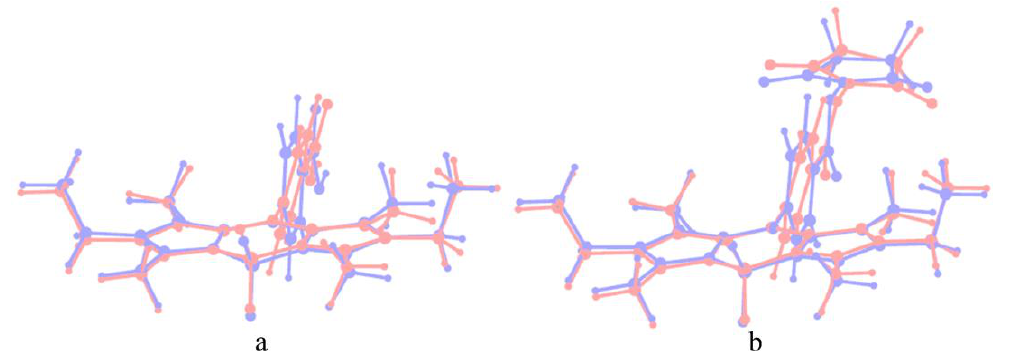
Figure 3. Ground S 0 (blue) and first excited S 1 (red) molecular geometry comparison for COOH-Ph-BODIPY ( a ) and NHS-Ph-BODIPY ( b ).